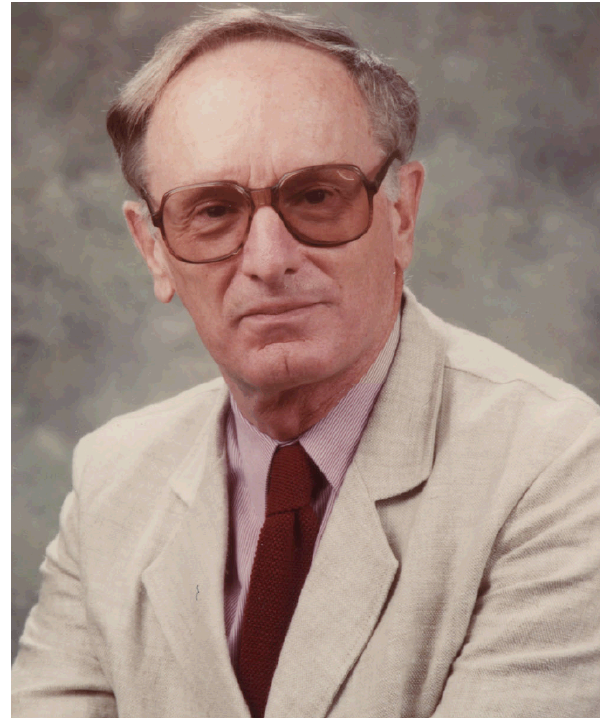
Figure 1. Photo of Cecil E. “Chuck” Leith. From Zhou and Her- ring